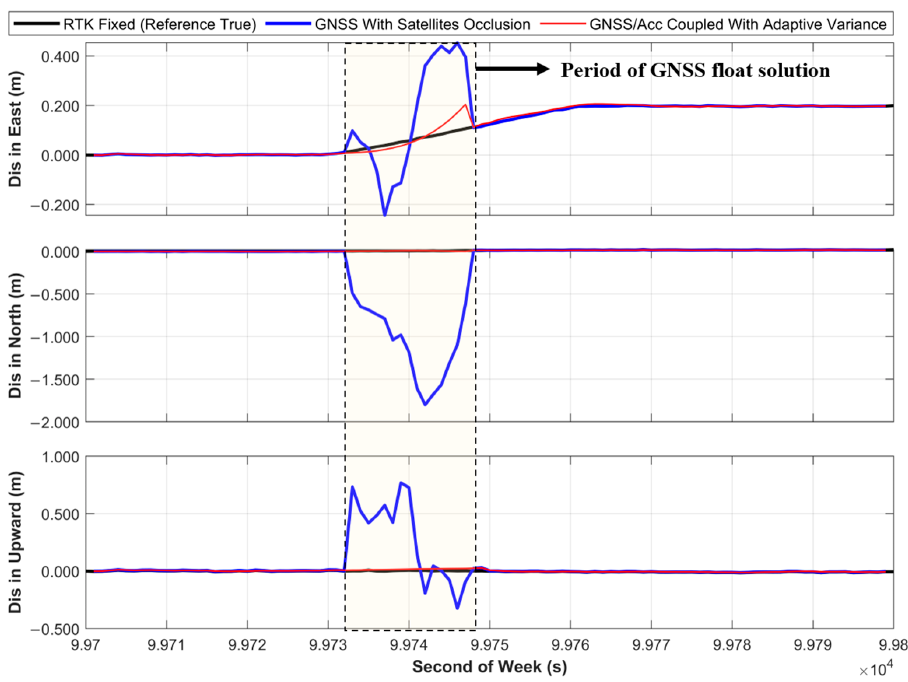
Figure 14. Coupled displacement results of the simulated landslide sliding period in Scene 2.2.